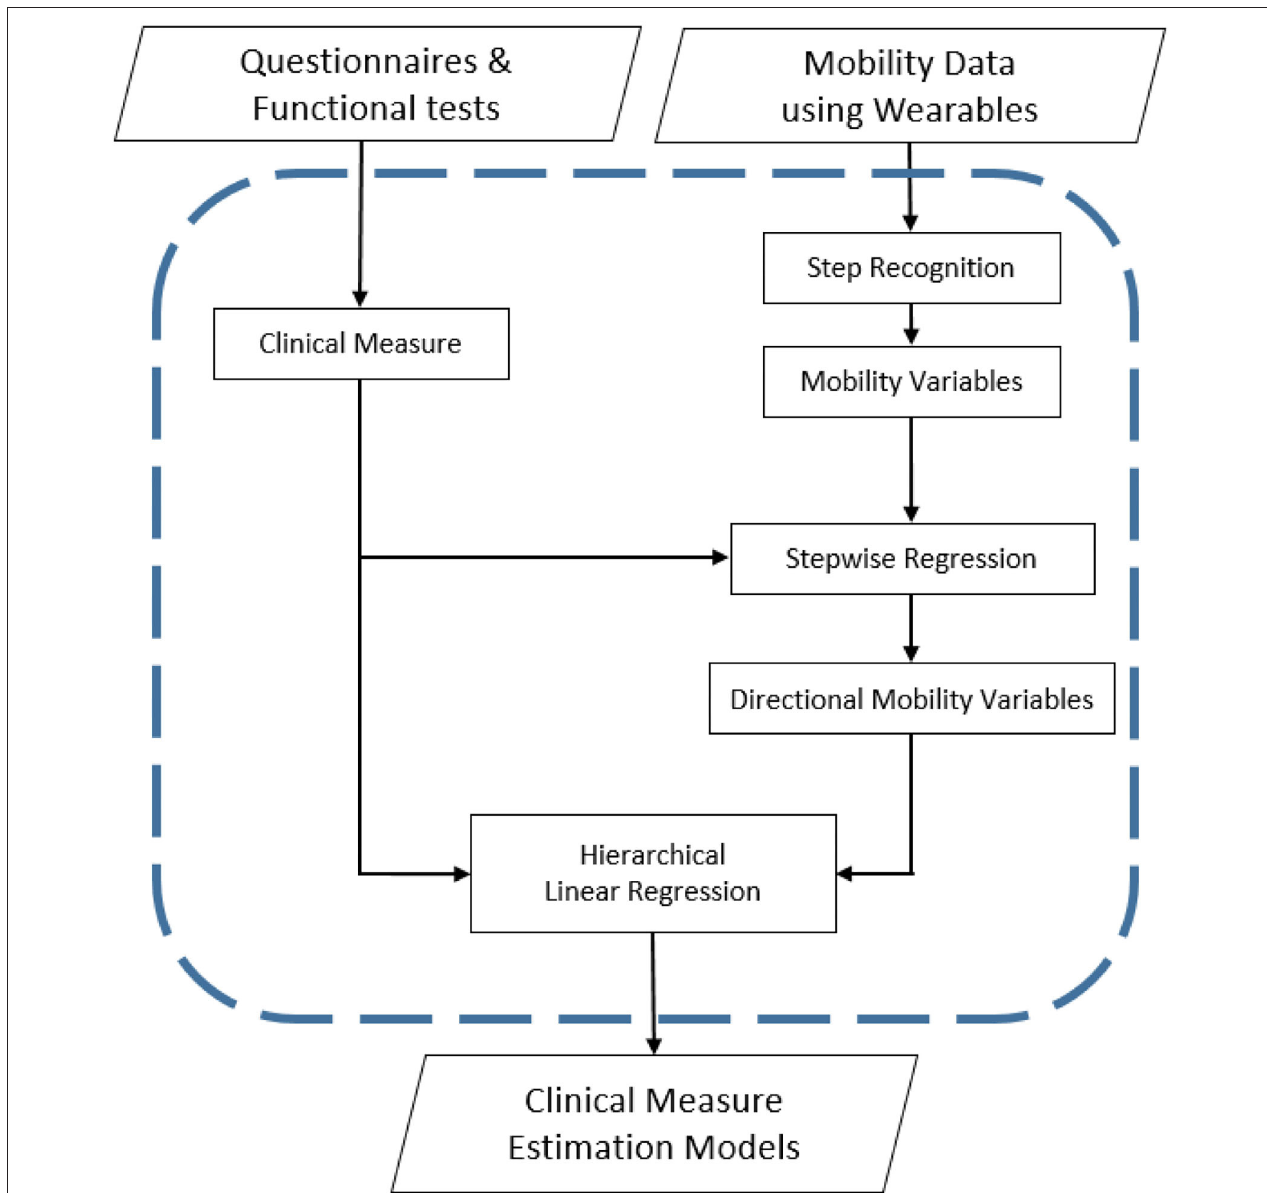
FIGURE 1 | Step by step study methodology for developing clinical measure estimation models.